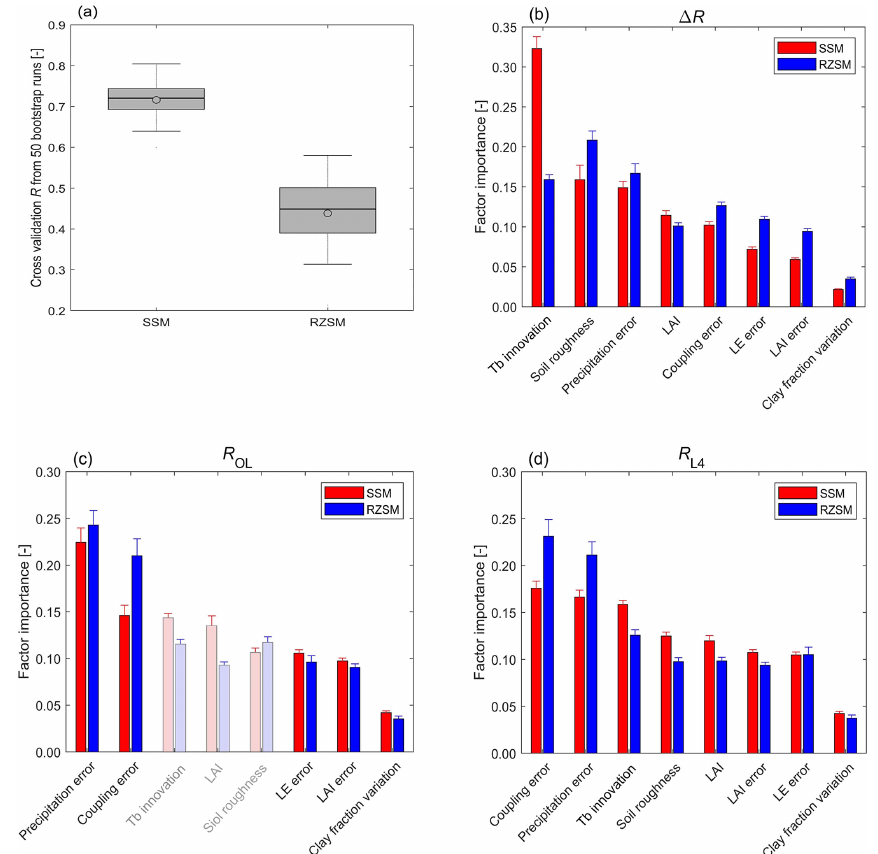
Figure 5. Attribution analysis of SMAP L4 DA skill improvement: (a) cross-validation of RF regression method in predicting DA skill improvement (cid:49)R = R L4 − R OL based on our eight control factors (Table 1). Relative importance of eight control factors determining spatial patterns in (b) DA skill improvement ( (cid:49)R ), (c) OL performance ( R OL ), and (d) L4 performance ( R L4 ). Red (blue) bars represent predictor importance for SSM (RZSM). Error bars reflect the standard deviation from 50-member bootstrapping of the RF importance estimates. Since RTM-related errors do not impact the SM skill in the OL simulation, the corresponding bars in panel (c) are shown as semi-transparent (see text for